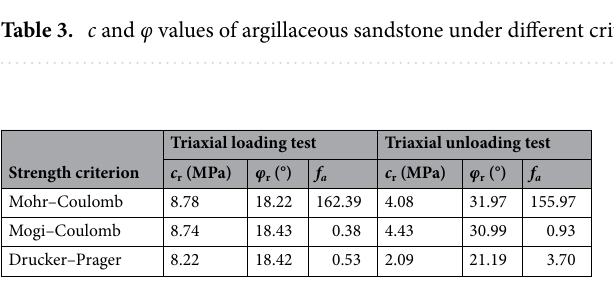
Table 4. c r and φ r values of argillaceous sandstone under different